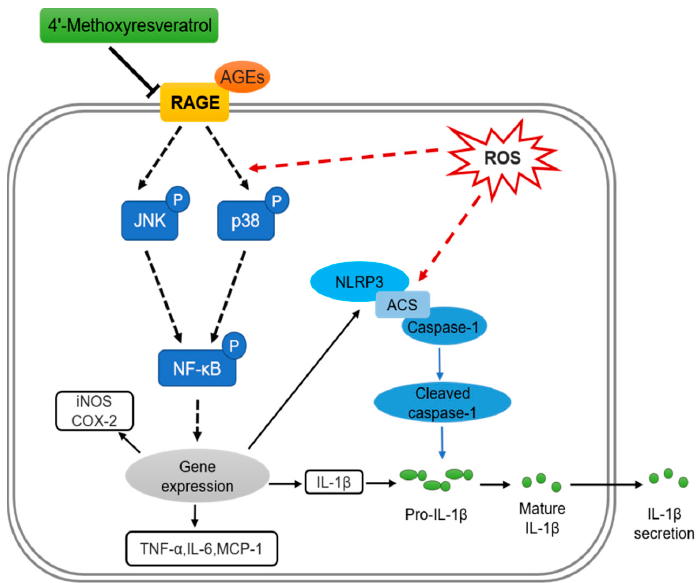
Figure 6. Schematic representation of protective effects of 4 ′ -Methoxyresveratrol against MB-induced cell disorders in RAW264.7 cells.